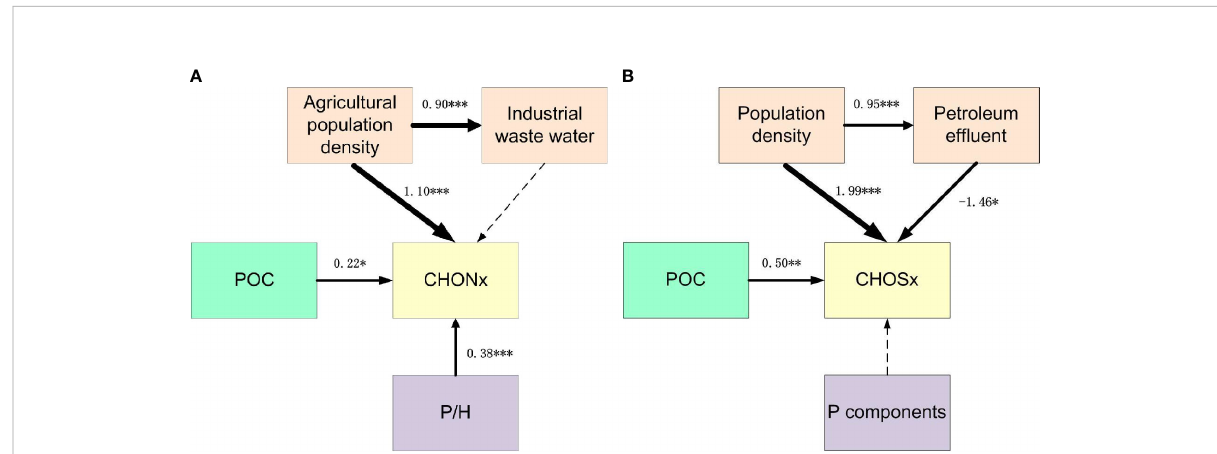
FIGURE 7 Path diagrams estimating direct and indirect effects on DOM elemental compositions. (A) Effects on CHONx; (B) Effects on CHOSx. Solid lines represent signi fi cant effects (p<0.05), and dashed lines represent insigni fi cant effects. Numbers adjacent to the arrows are standardized path coef fi cients, *p<0.05, **p<0.01,